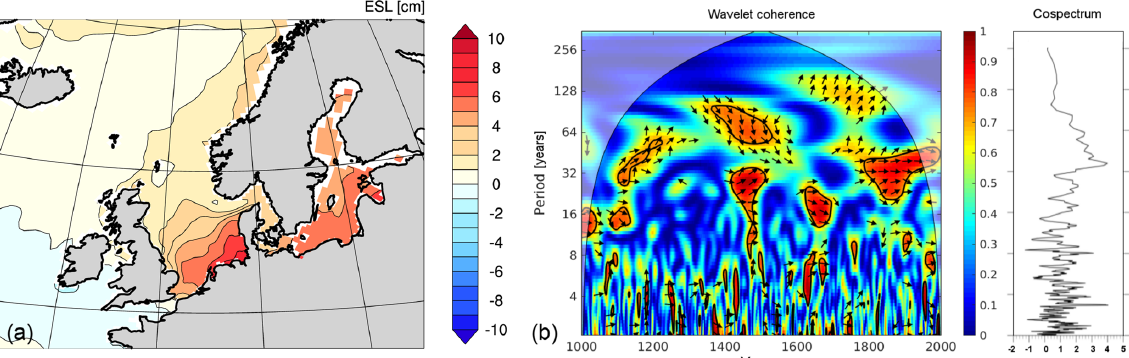
Figure 10. (a) Pointwise regression of the SLP index derived from Fig. 9 onto annual maximum sea level (color shading, meters per unit of SLP index). (b) Wavelet coherence and cospectrum between annual maximum sea level at Cuxhaven and the tailored SLP index. Arrows to the right (left) indicate a positive (negative) correlation and upward (downward) arrows indicate a lag (lead) of ESL at Cuxhaven. Thick contours designate the 5% significance level against red noise; the cone of influence is shown in a lighter